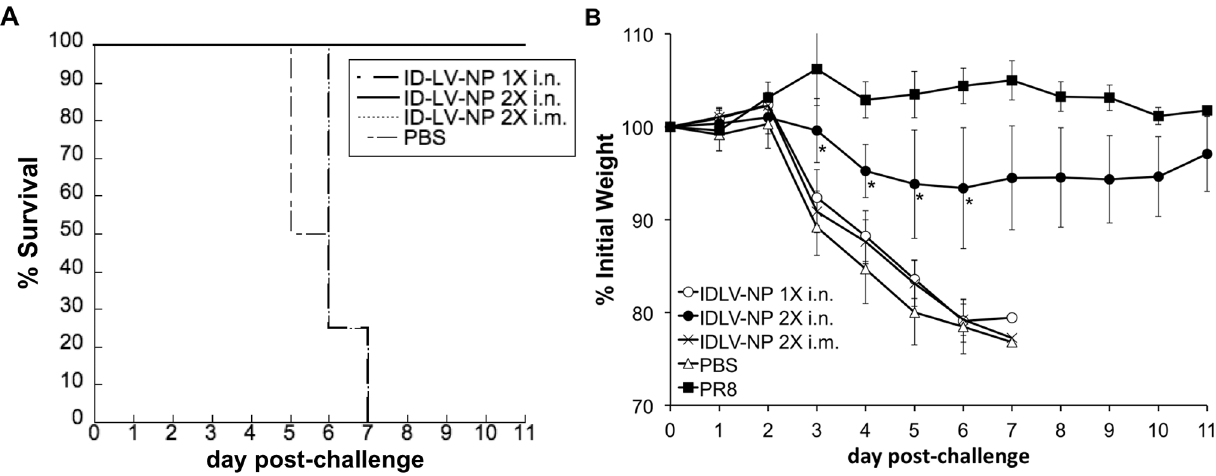
Figure 6. Immunization with IDLV protects mice from homologous influenza challenge. Groups of mice (n=4) were immunized 1 or 2 times, 4 weeks apart, with IDLV-NP via either the i.m. or i.n. route of administration. Mice that were injected i.m. with PBS served as a negative control, and mice that were infected i.n. with a sublethal dose of PR8 influenza virus served as a positive control for protection. Survival ( A ) and weight loss ( B ) were monitored for 11 days following i.n. challenge with a lethal dose (10 LD 50 ) of PR8 influenza virus 4 weeks after the final inoculation. Weight loss is presented as the average percentage of initial weight at the time of challenge. *indicates days when IDLV-NP 2X i.n. lost significantly less weight than any of the other immunization regimens (p , 0.001, calculated using pairwise group comparisons, at each time point, based on ANOVA). Overall p-value for group comparisons was based on the Kruskal-Wallis test: p=0.001 for day 3, p=0.002 for day 4, p=0.005 for day 5, p=0.008 for day 6.